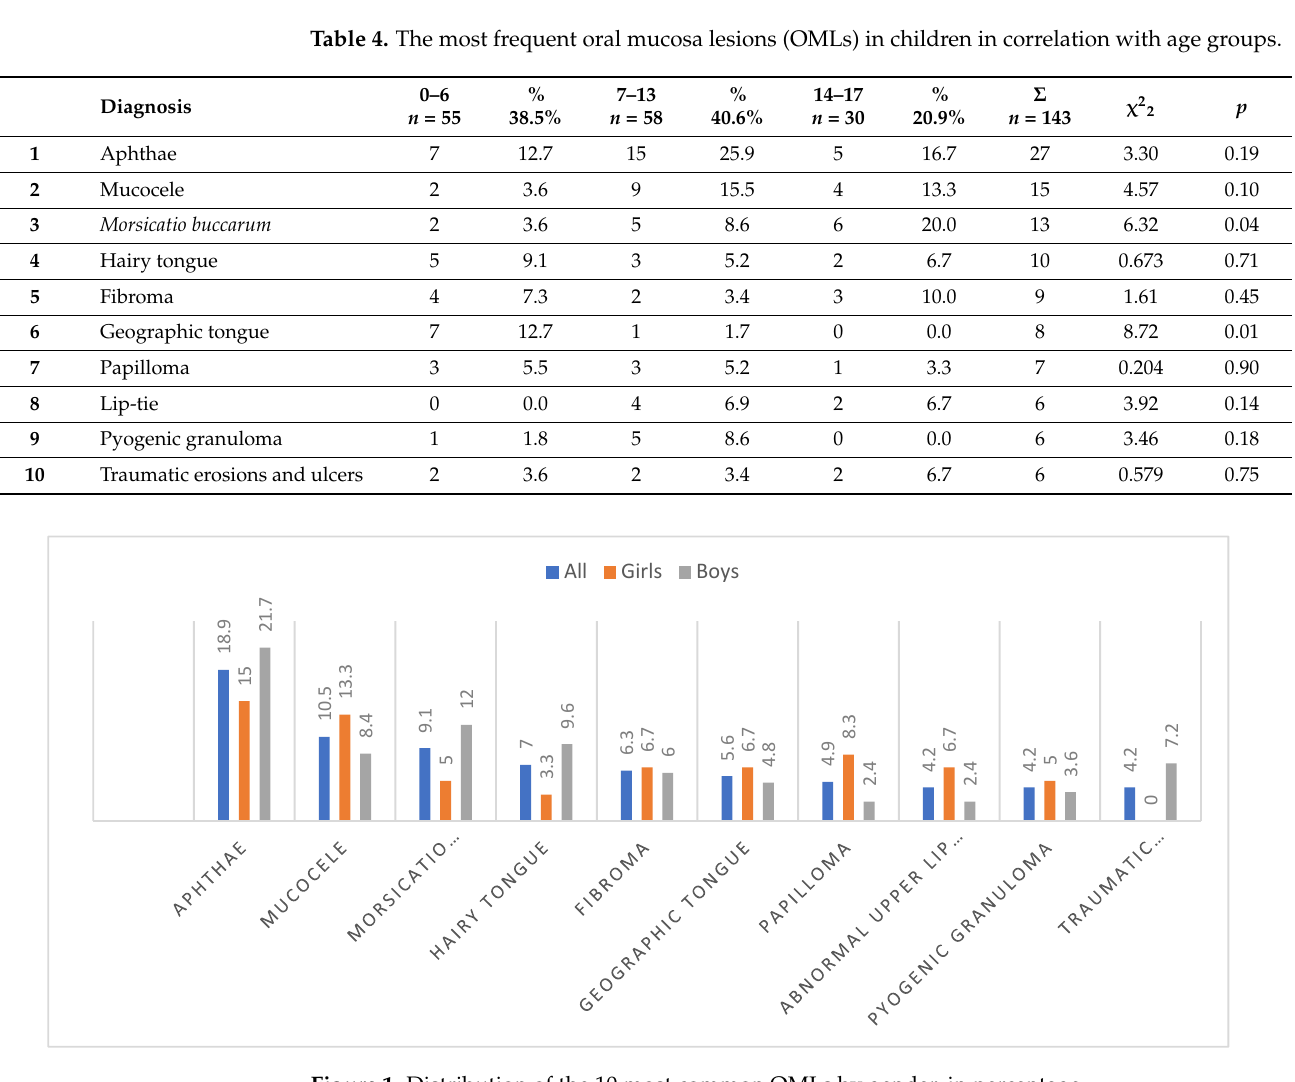
Table 4. The most frequent oral mucosa lesions (OMLs) in children in correlation with age groups.